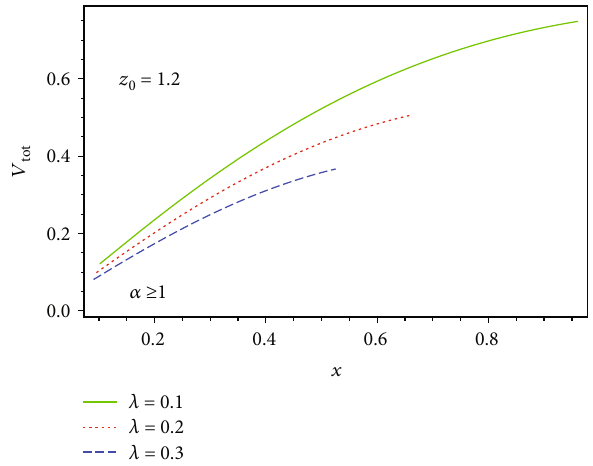
Figure 4: Considering behaviour of potential during pair production at zero temperature.